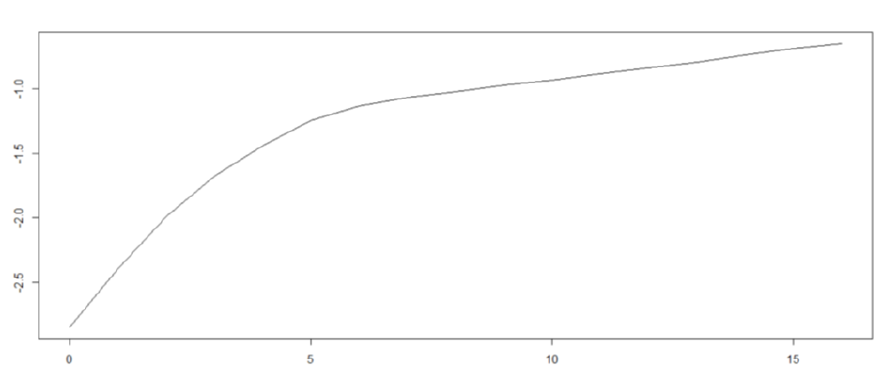
Figure 12: Average log distances and the iteration of initially nearby points -Natural Gas; Source: Author The results of the analysis are depicted in Figures 10, 11 and 12. These figures plots the output of Eq. (7) for each of the series. In Eq. (7), embedding dimension parameter for each of the financial time series is taken according to output of Eq.(6). It can be easily obtained from Figure 7,8 and 9. In Figure 10, the maximal Lyapunov exponent, 𝜆 𝑚𝑎𝑥 (𝜏) is computed from the slope of the curves according to Eq. (7). The slope is positive and is equal to 0.07313397 on average. In Figure 11, the maximal Lyapunov exponent, 𝜆 𝑚𝑎𝑥 (𝜏) is equal to 0.1356972 and finally in Figure 12, 𝜆 𝑚𝑎𝑥 (𝜏) = 0.09331731. The negative values derive from the logarithm of the interval's distances (0,1]. The 𝜏 value(s) where the slope of the curves approximates zero is denoted by 𝜏 𝑚𝑎𝑥 and signifies the last step of the scaling range, implying that the dynamic system is still predictable. For Crude Brent oil data, 𝜏 𝑚𝑎𝑥 = 17 and for Global food index 𝜏 𝑚𝑎𝑥 = 11. For the iterations exceeding this value 𝜏 ∗ > 𝜏 𝑚𝑎𝑥 , the points are no more affected by the chaotic attractor. Thus, the system investigated is said to jump through an unpredictable state. From Figure 10 and Figure 11 it is straightforward that the data examined show chaotic behaviour associated with the positive maximal Lyapunov exponent. However, Figure 12 depict that within certain iteration interval, the average log distance does not converge and saturate. Therefore, it cannot be determined clearly determined